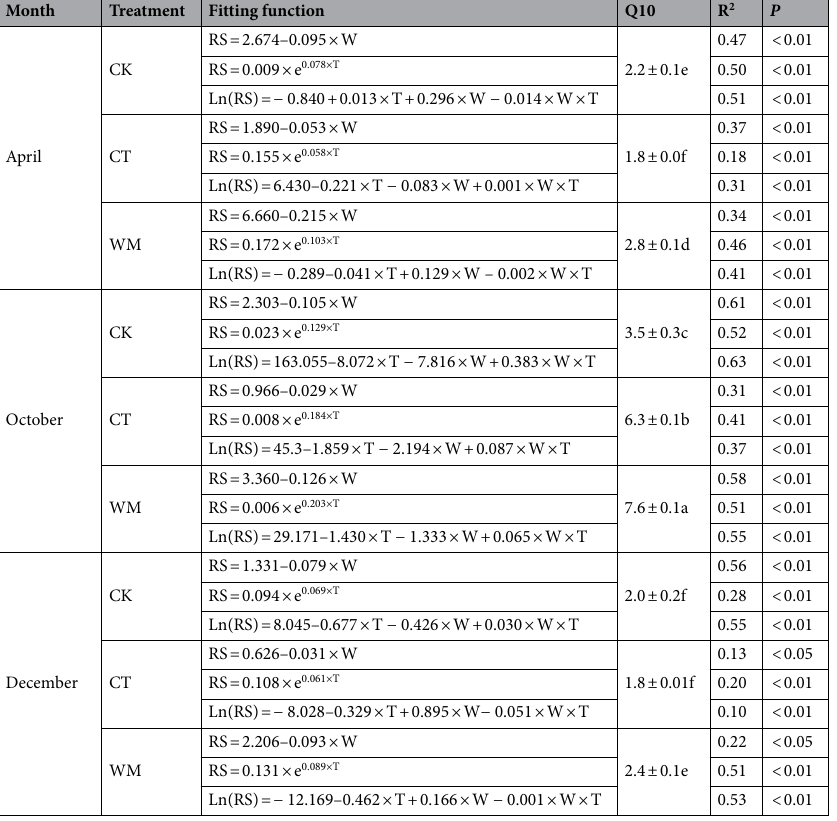
Table 2. Correlations of the diurnal soil daytime respiration with the soil temperature and soil moisture. RS, soil respiration; T, soil temperature; W, soil water content; CK, natural coastal wetland; CT, cotton mono- cropping farmland; and WM, wheat–maize rotation cropping farmland. Different letters in the same column indicate significant variance by T-test at p <